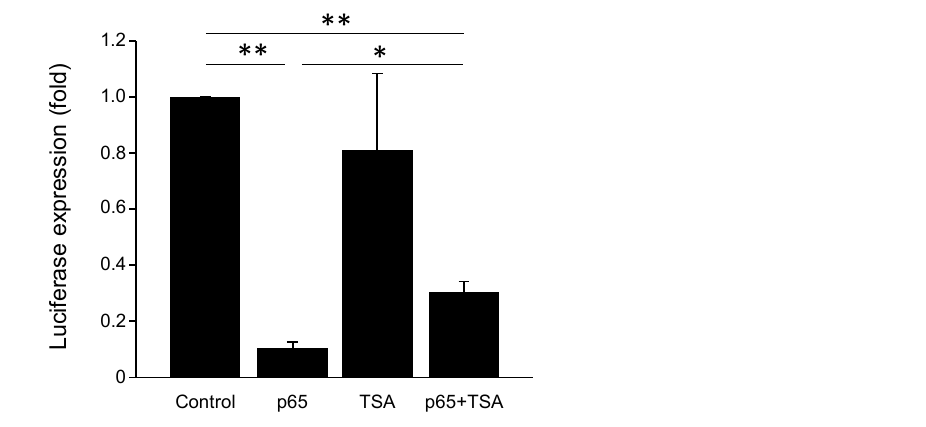
Figure 7. Luciferase reporter assay for the PGC-1α promoter. Cardiac myocytes were transduced with empty vector (Control) or a vector encoding NF-κB p65 subunit and PGC-1α promoter reporter and monitored for PGC-1α promoter activity in the absence and presence of trichostatin A (TSA, 10 μM). TSA alone did not affect PGC-1α promotor activity, whereas TSA in the presence of NF-κB p65 vector partially reversed the decrease in PGC-1α promotor activity by p65. * p < 0.05 or ** p < 0.01 versus indicated sample.